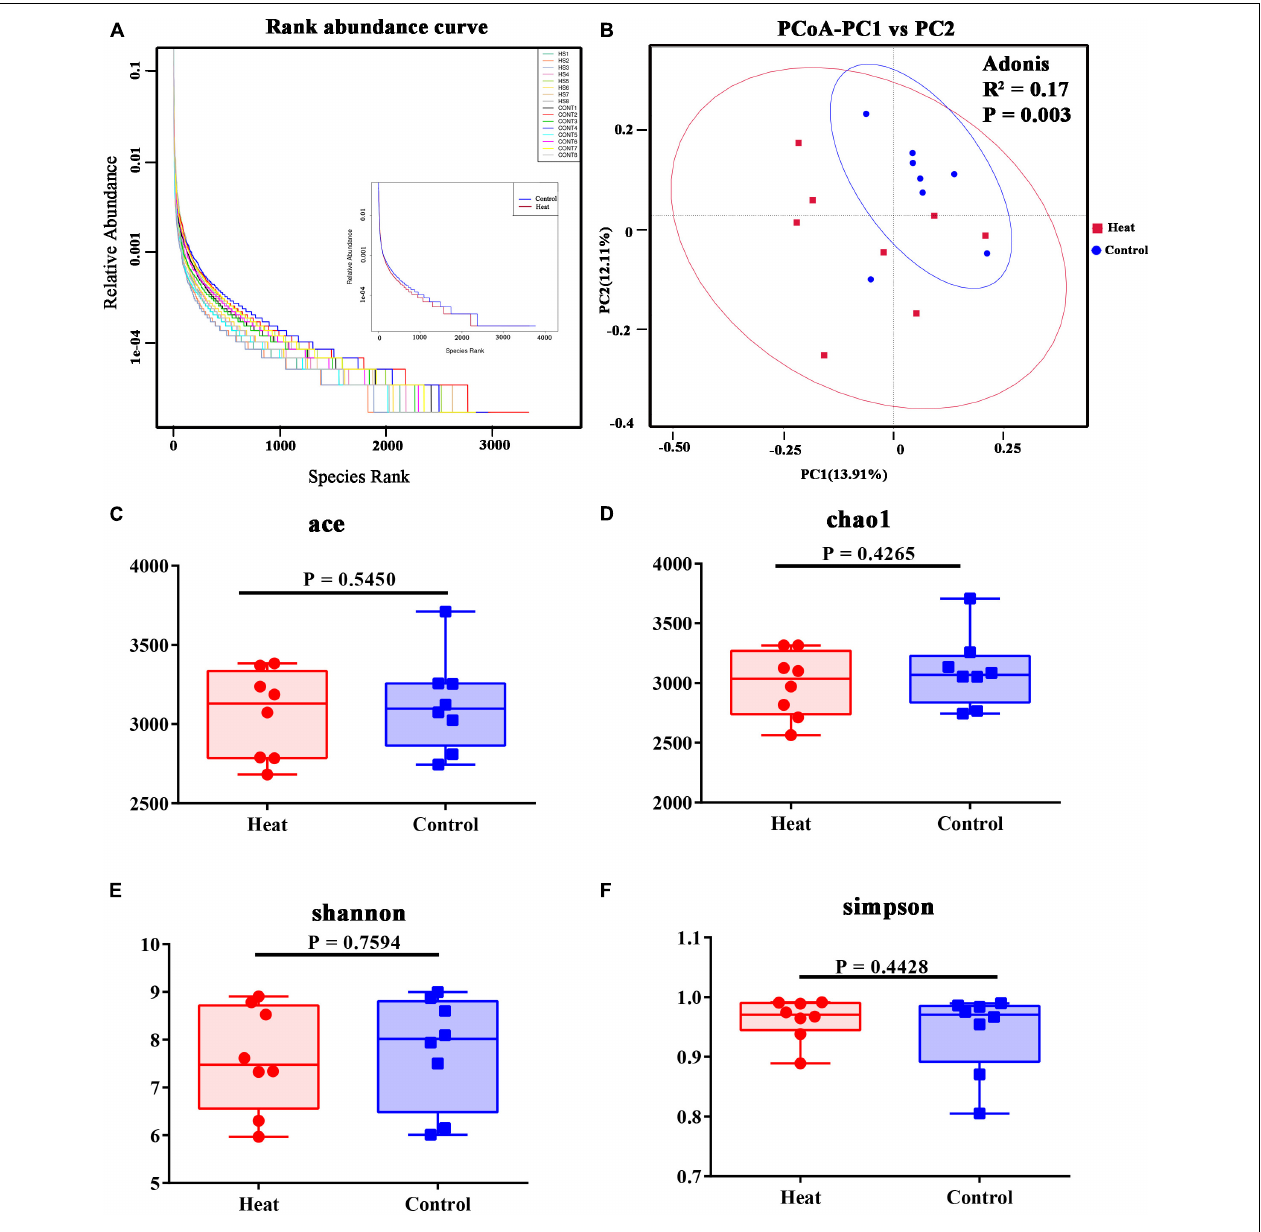
FIGURE 2 | Diversities of vaginal microbiota of rabbit. (A) The rank abundance curve of 16 rabbits, and in the right, HS1–HS8 indicate the eight individual animals in the Heat group, and CONT1–CONT8 indicate the eight individual animals in the Control group. The right part of the diagram displays the average species rank of the two groups. (B) PCoA analysis and Adonis analysis of microbial communities. R2 indicates the explanation degree of the grouping method for the difference between samples. The greater R2, the higher the explanation degree of the grouping method for the difference. P < 0.05 indicates the reliability of this inspection